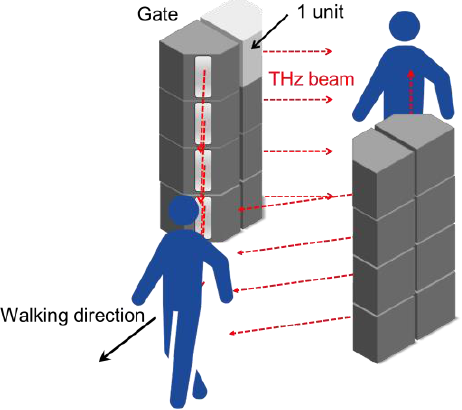
Figure 1. Concept diagram of walk-through body scanner.